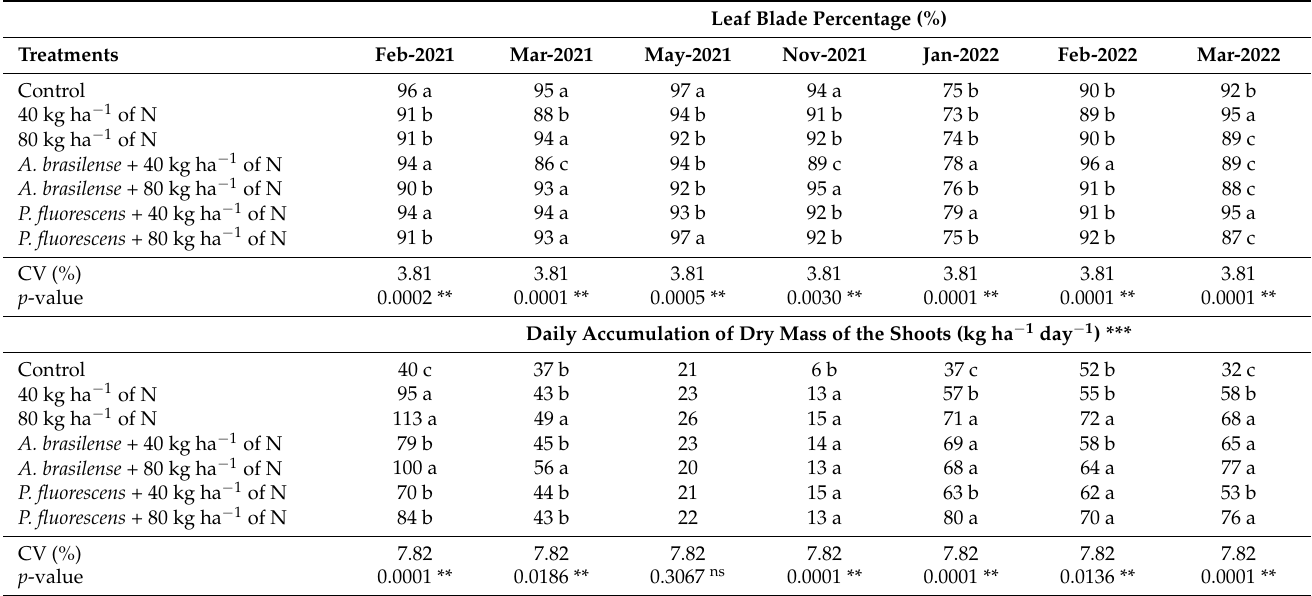
Table 4. Mean leaf blade percentage and average daily accumulation of dry mass of the shoots of Megathyrsus maximus cv. BRS Zuri inoculated with